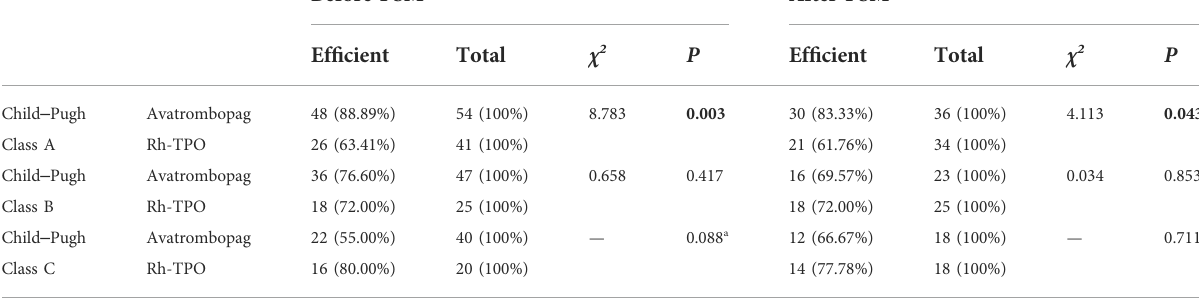
TABLE 2 Effective rate of drug therapy according to Child – Pugh